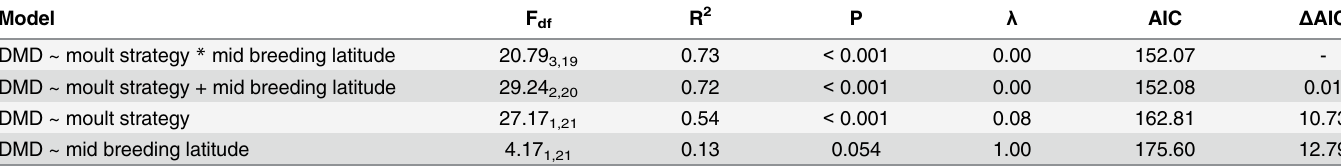
Table 1. Statistical, phylogenetic signal ( λ ), AIC and Δ AIC for tested models.